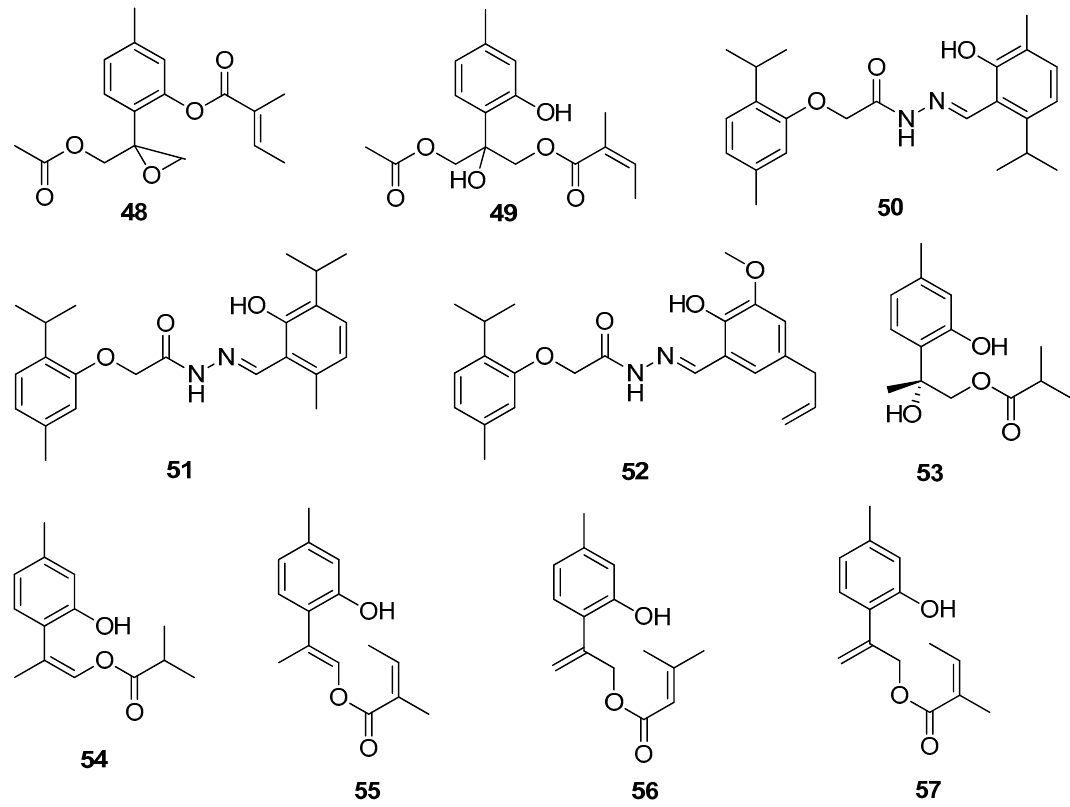
Figure 12. Thymol derivatives with anticancer activity.